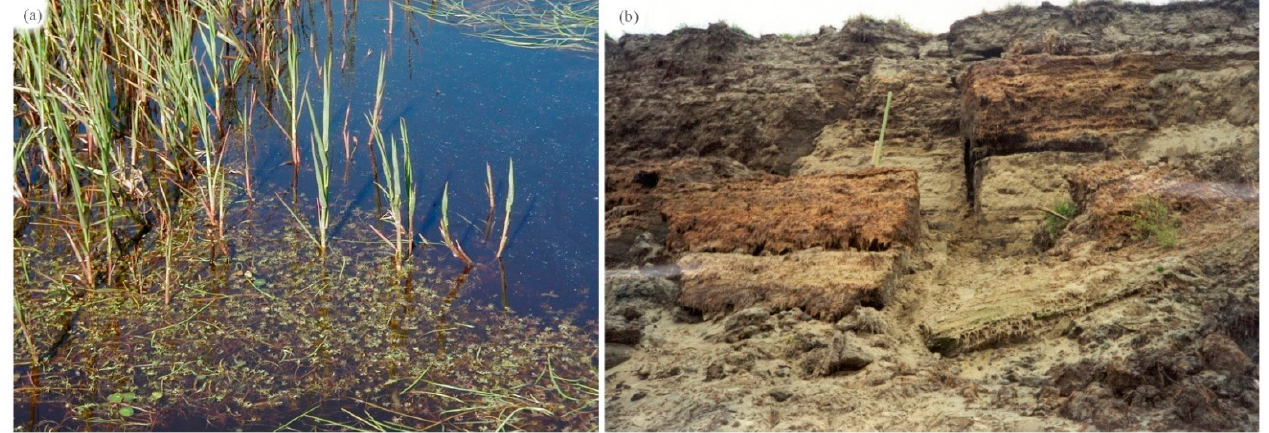
Figure 8. Grass-rich sedimentation: ( a ) grassy edge of a water body in the tundra near Anadyr, Chu- kotka. ( b ) Grassy deposits in the Holocene section on the Samoylov Island, Lena Delta.